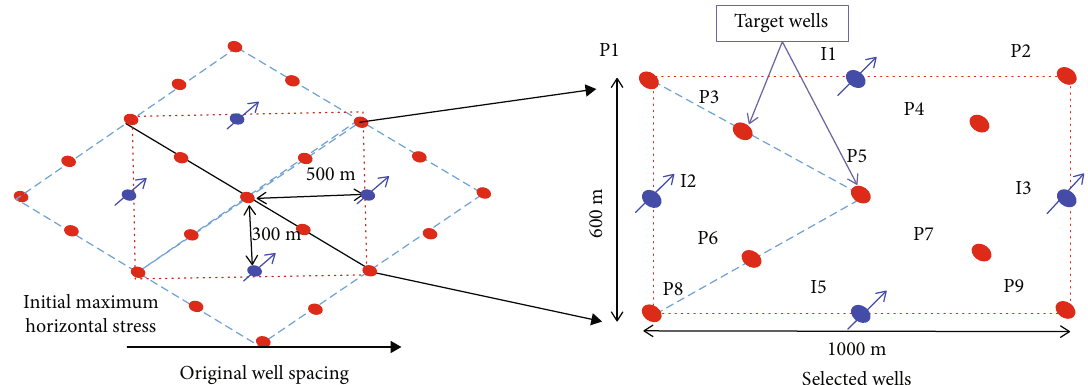
Figure 8: Diagram of the well pattern for numerical simulation.